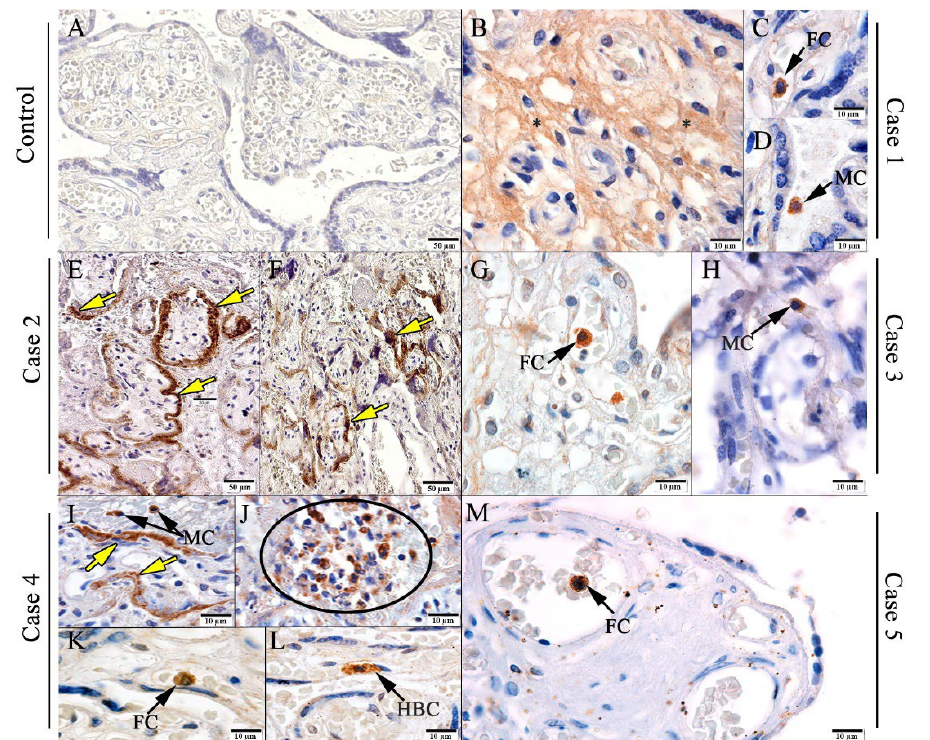
Figure 3. Detection of spike protein in placental cells. ( A ) Pre-pandemic control placenta. ( B – M ) Spike protein detected in: ( B – D ) Representative microphotographs of SARS-CoV-2 infected placentas. HBC—Hofbauer cells; FC—circulating cells of fetal capillary; yellow arrows—trophoblastic cells; MC—macrophages.